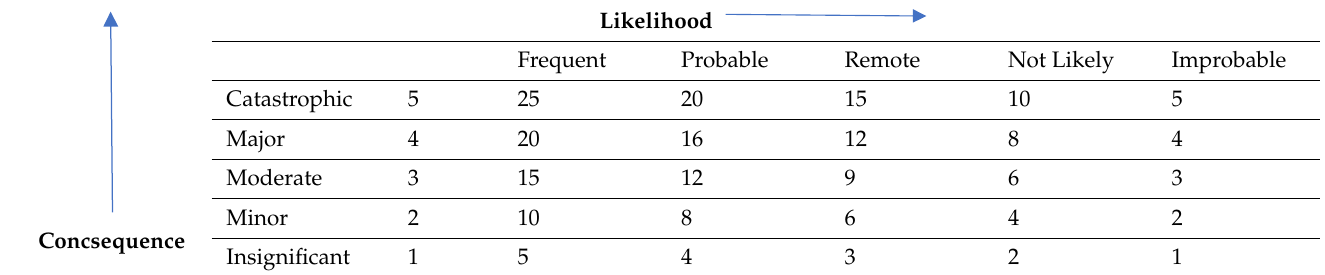
Table 3. Risk matrix.